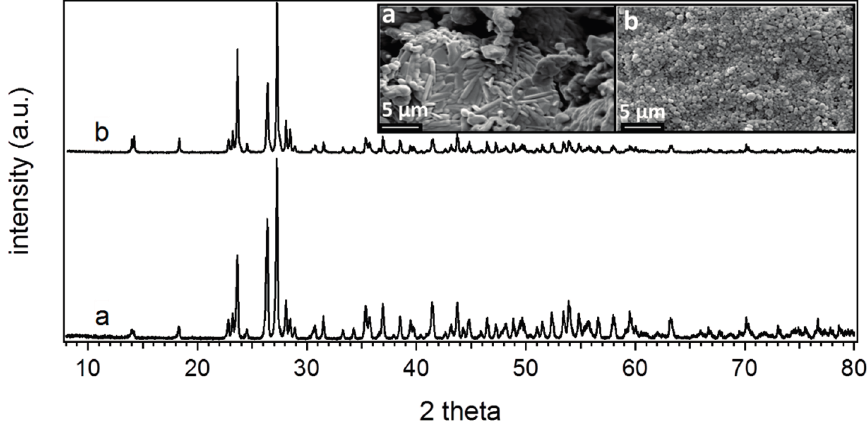
Figure 2. Powder X-ray diffractograms of ( a ) as-received powder pulverized with a